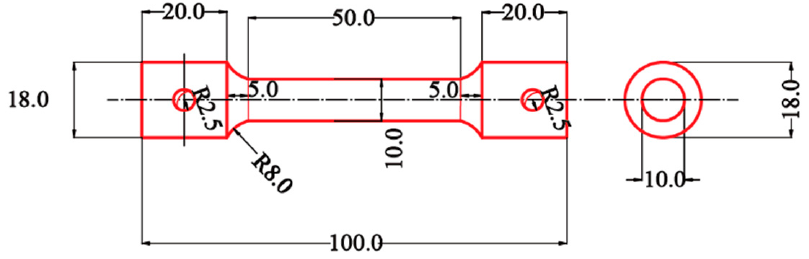
Figure 5. Dimensional drawing of tensile specimen(unit: mm).